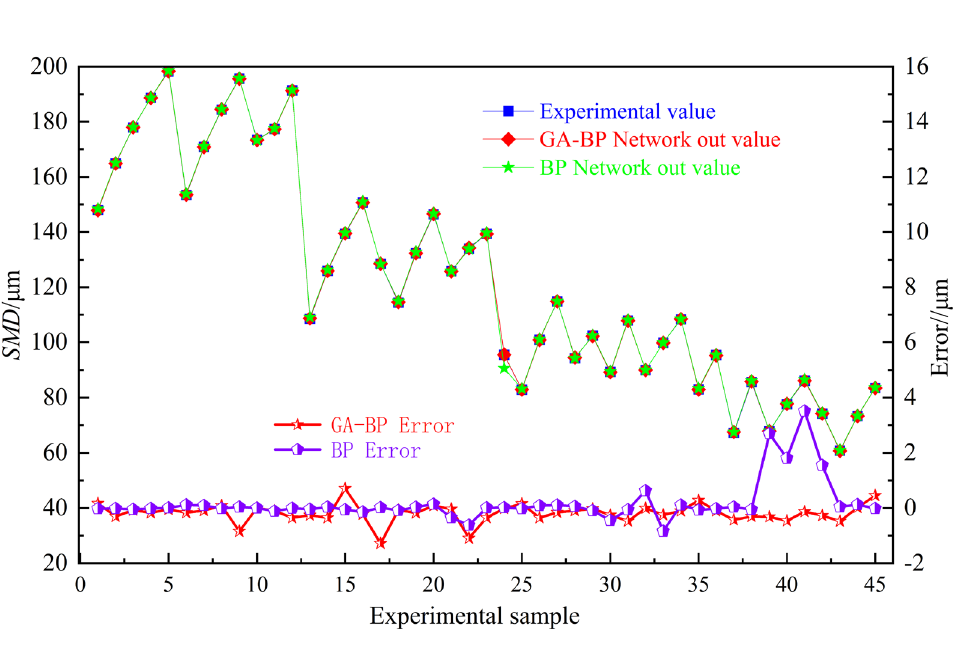
Figure 9. GA-BP fitness response curve.